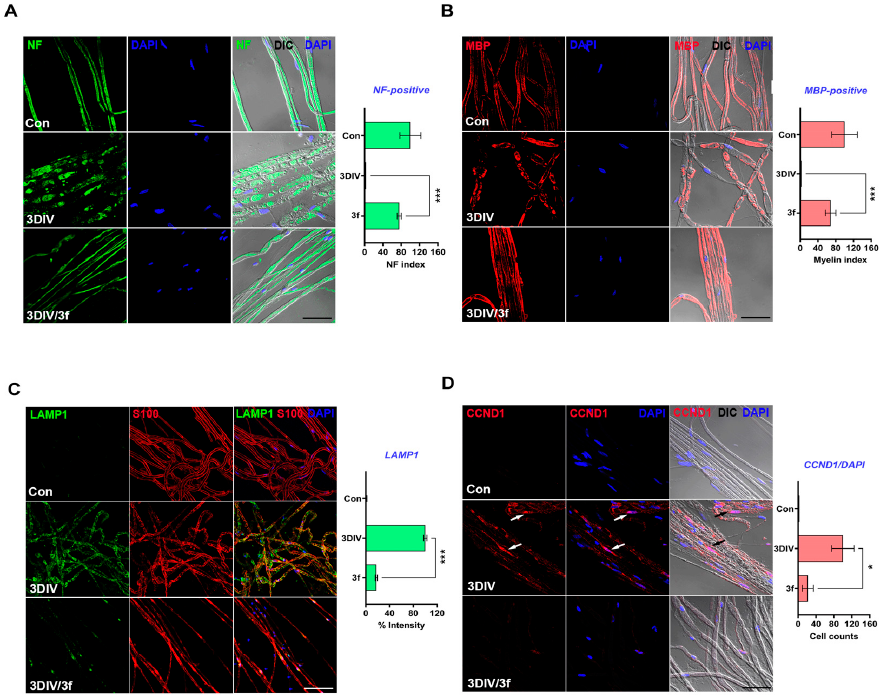
Figure 5. Inhibitory effect of 3f on the phenotypes of PND. ( A ) Immunostaining was performed in explant sciatic nerve fibers. Neurofilament (NF, green) and 4 (cid:48) ,6-Diamidine-2 (cid:48) -phenylindole (DAPI, blue) were used as markers for axons and nucleus, respectively. NF index was calculated by counting the 100 µ m-long consecutive lines (n = 3 mice). Scale bar, 50 µ m. 3DIV, 3 days in vitro. Con, control. ( B ) Myelin sheath was identified using an anti-myelin basic protein (MBP, red) antibody counterstained with DAPI. Scale bar, 50 µ m. MBP index was estimated by calculating the 100 µ m-long consecutive lines of MBP-marked nerve fibers (n = 3 mice). ( C ) Immunostaining with lysosomal- associated membrane protein 1 (LAMP1, green) combined with DAPI (blue) in ex vivo sciatic